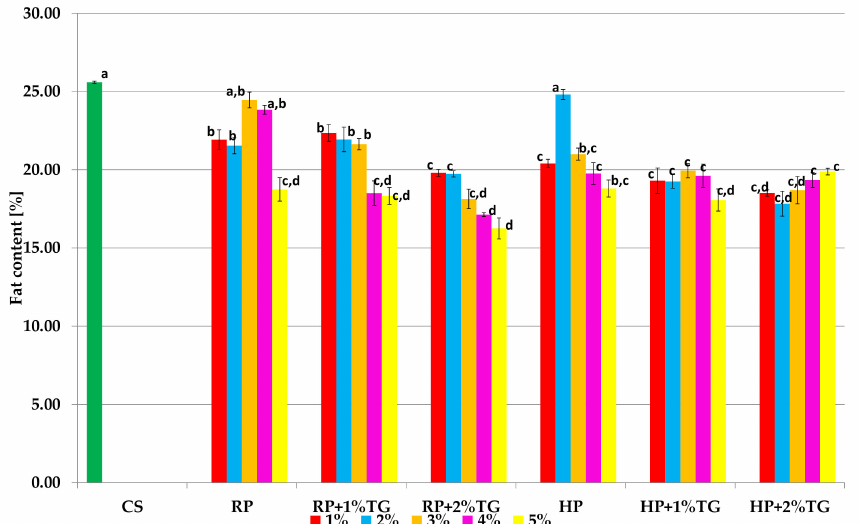
Figure 2. Average values of fat content in instant noodles with the addition of rice protein, hemp protein and TGase (CS—control sample, RP—rice protein, RP+1%TG—rice protein with 1% TGase, RP+2%TG—rice protein with 2% TGase, HP—hemp protein, HP+1%TG—hemp protein with 1% TGase, HP+2%TG—hemp protein with 2% TGase). Columns correspond to various addition of rice protein. Mean values denoted by different letters ( a – d ) represent statistically significant differences between variables ( p <